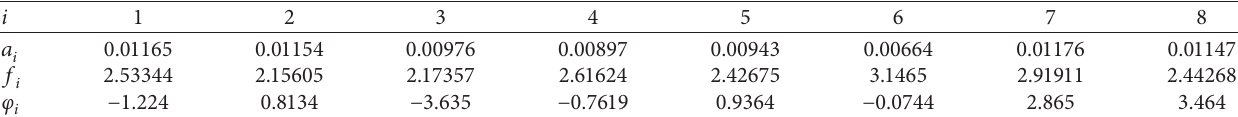
Table 5: Values of 24 fitting parameters in equation (1) in 80 ∼ 100s.